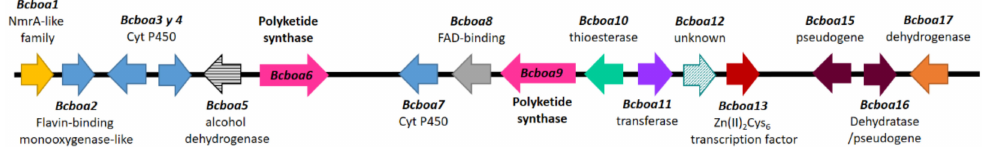
Figure 6. BOA gene cluster in the genomes of B. cinerea strain